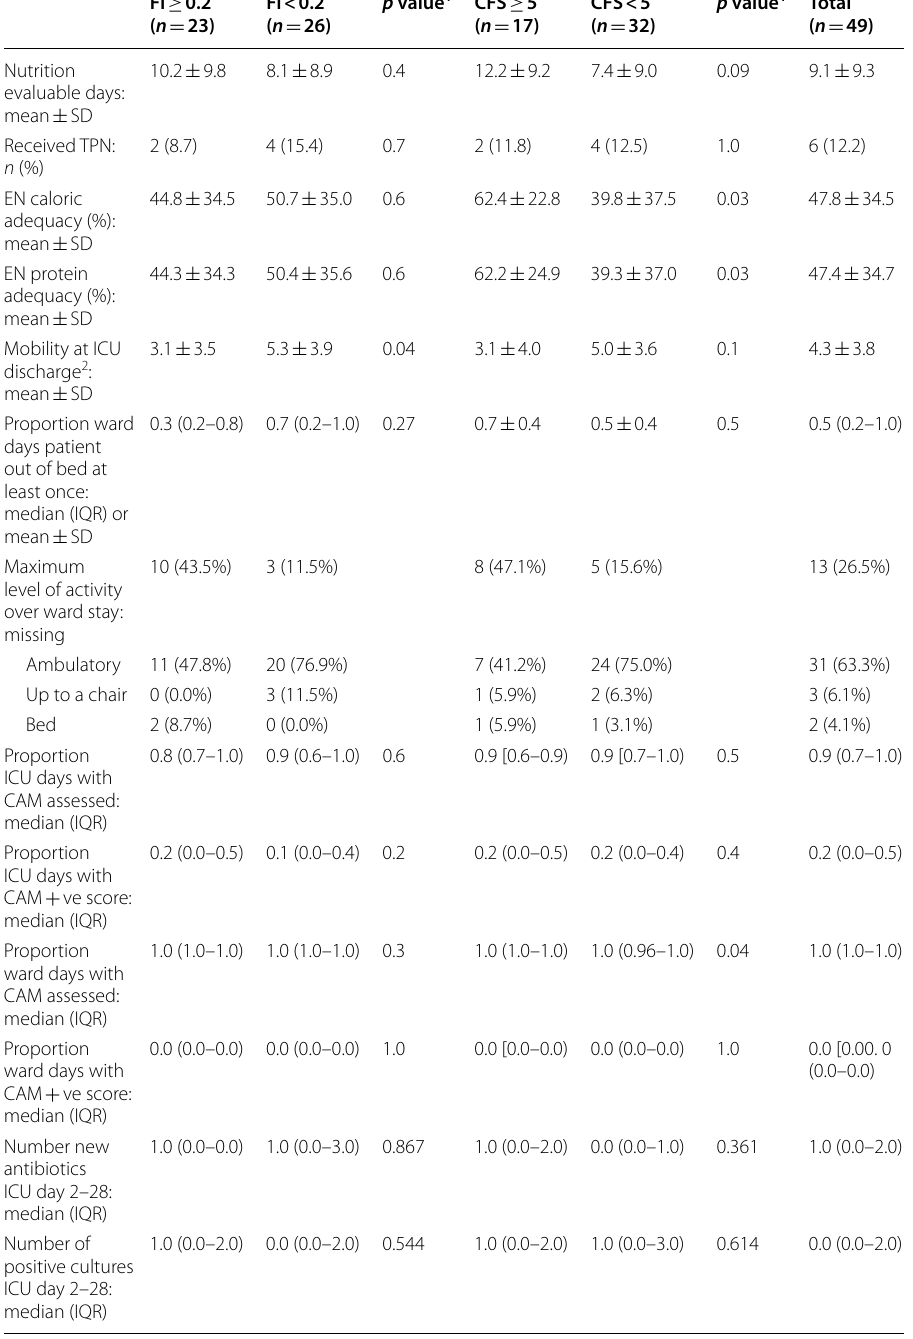
Table 3 Care processes and adverse events during ICU and hospital